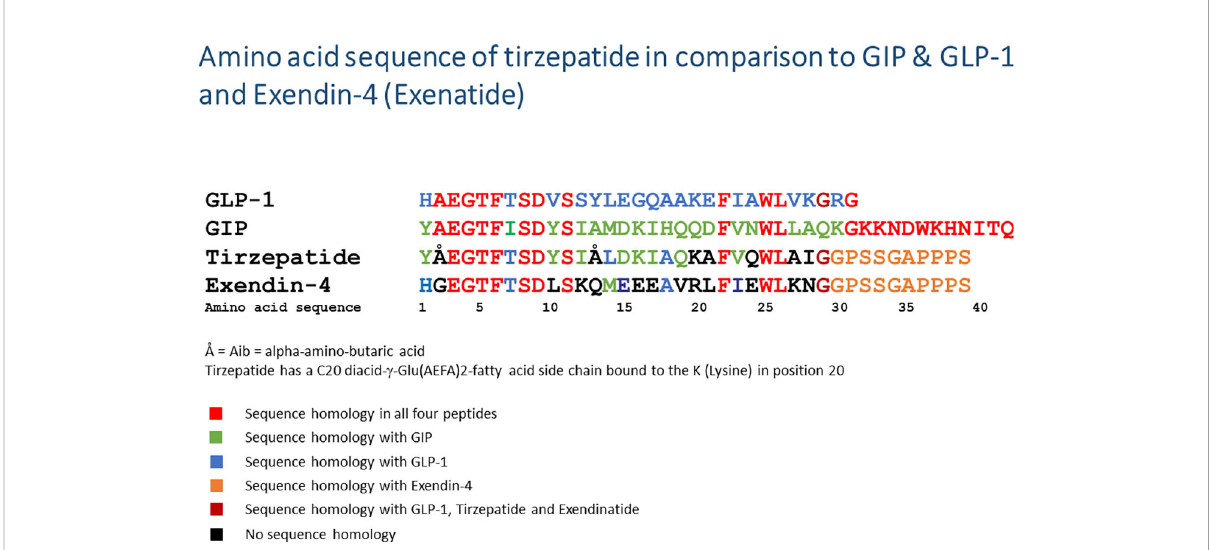
FIGURE 2 Amino acid sequence of tirzepatide in comparison to native GIP, GLP-1, and exendin-4 (exenatide). The amino acid sequences of the peptides are given in a one-letter code starting with the N-terminus on the left side. Å = Aib, alpha-amino-butyric acid; diacid- g -Glu(AEFA)2, the linker molecule linking a fatty acid side chain with a length of 20 carbon atoms (=C20) to the K (lysine) in position 20; GLP-1, glucagon-like peptide-1; GIP, glucose-dependent insulinotropic